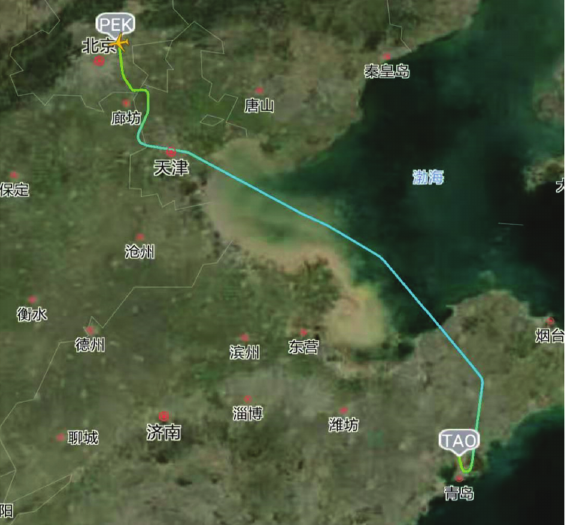
Figure 3: Flight Path from Qingdao to Beijing.